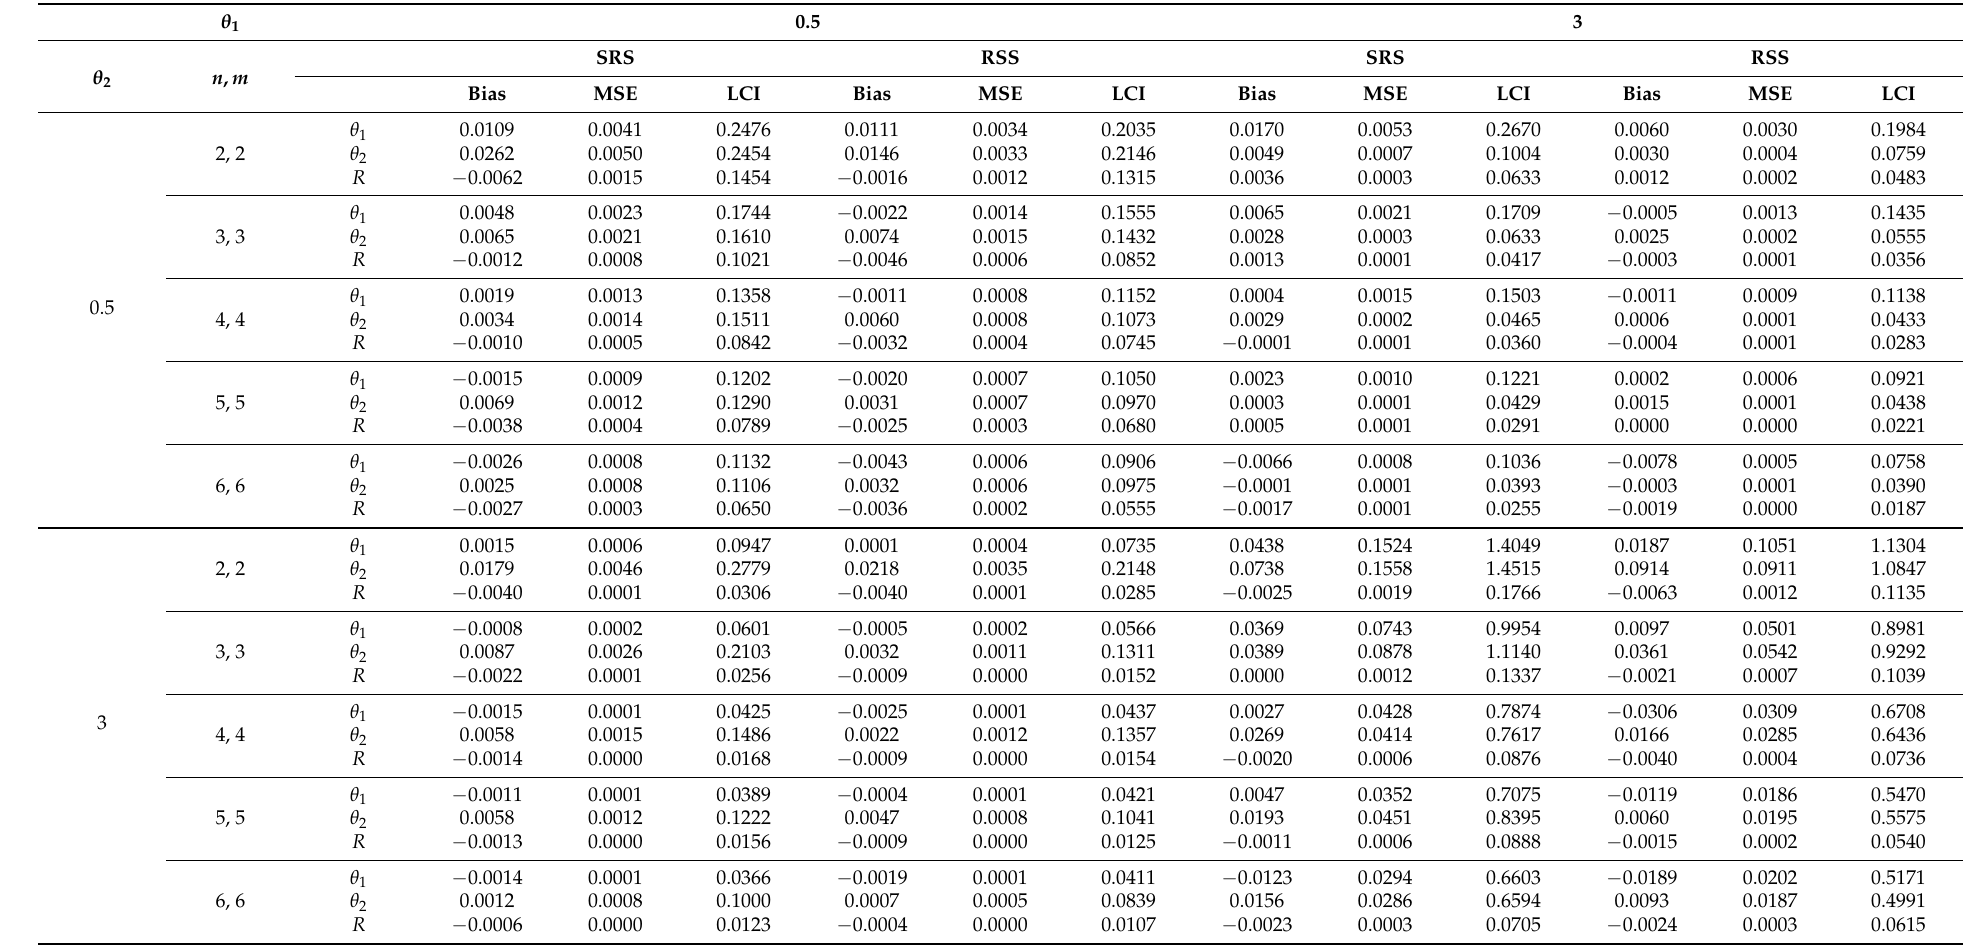
Table 2. SRS and RSS by Bayesian Method with Gamma Prior of Parameters and R of ITL Stress Strength